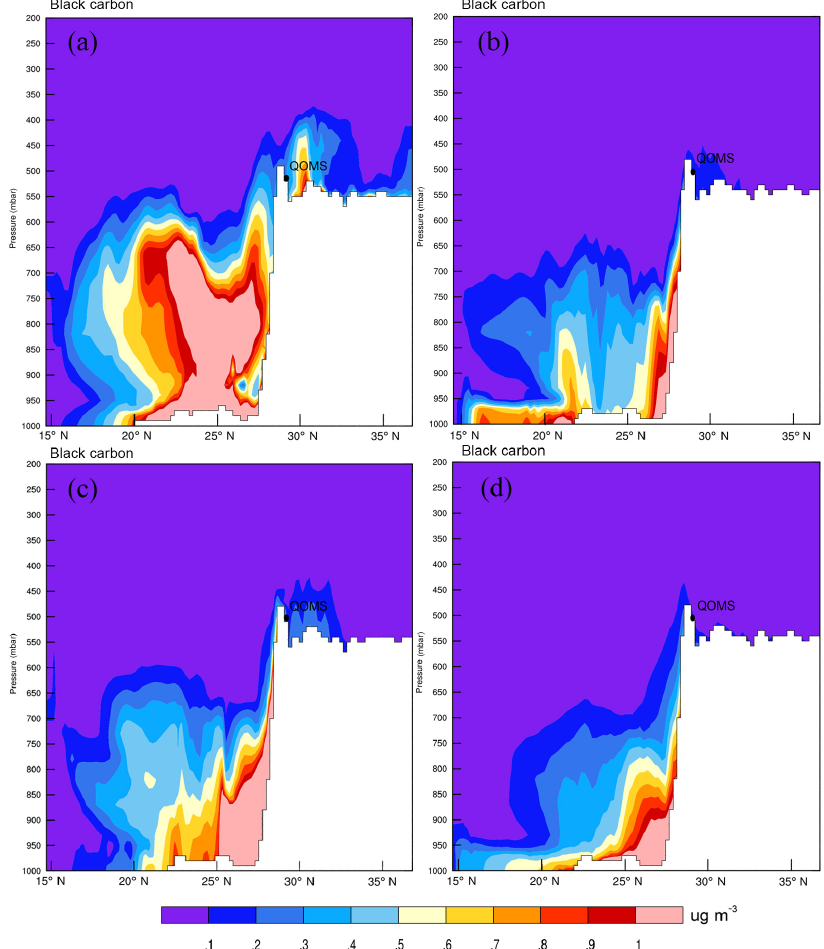
Figure 10. Vertical profiles of mean BC concentration along the QOMS’s longitude of 86.95 ◦ E: (a) event A; (b) event B; (c) event C; (d) event